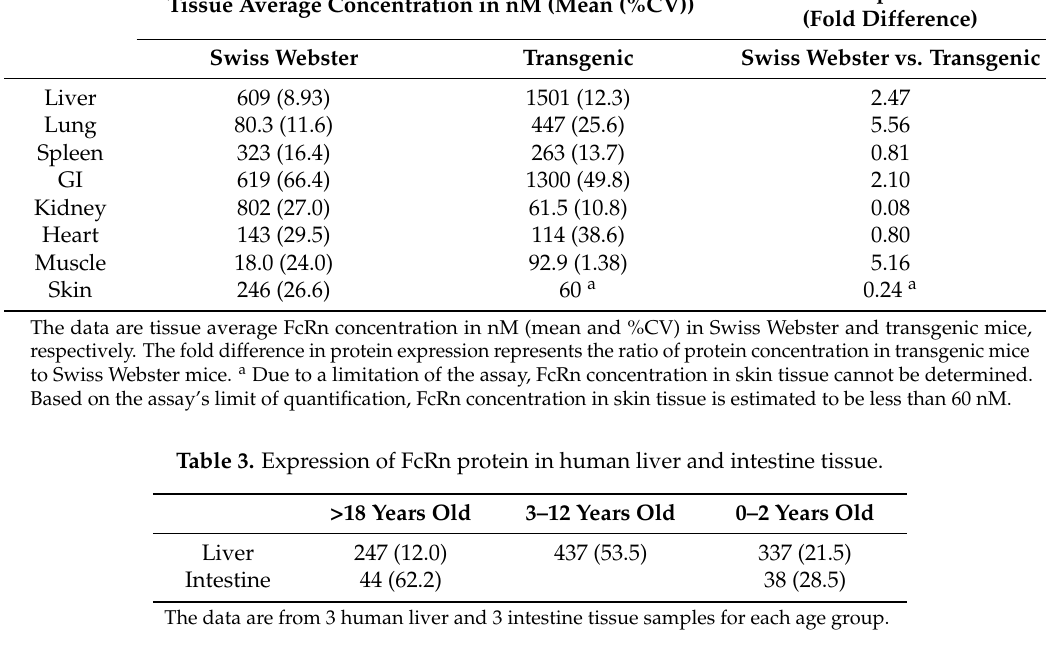
Table 2. Expression of mFcRn and hFcRn protein in various tissues of Swiss Webster and transgenic mice. Tissue Average Concentration in nM (Mean (%CV))